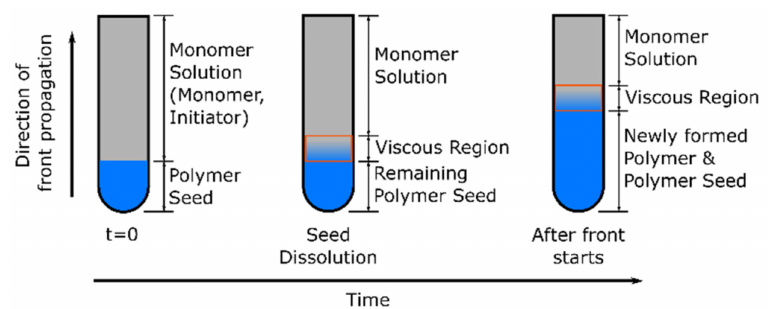
Figure 31. Schematic representation of isothermal frontal polymerizations